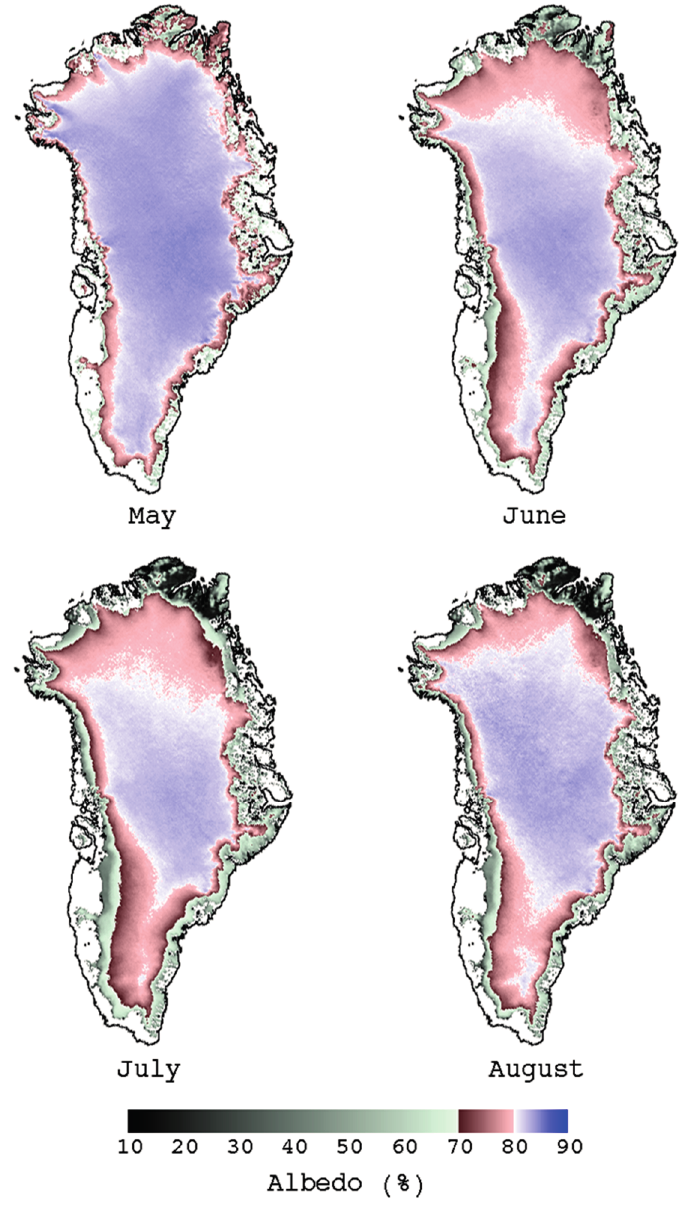
Figure 4. Example images produced through data rods processing. The Greenland Ice Sheet median monthly albedo is shown for the months of May through August, calculated from 25 years of albedo data, 1981 to 2005. Each grid point was temporally analyzed, and the statistical results were used to construct images of the